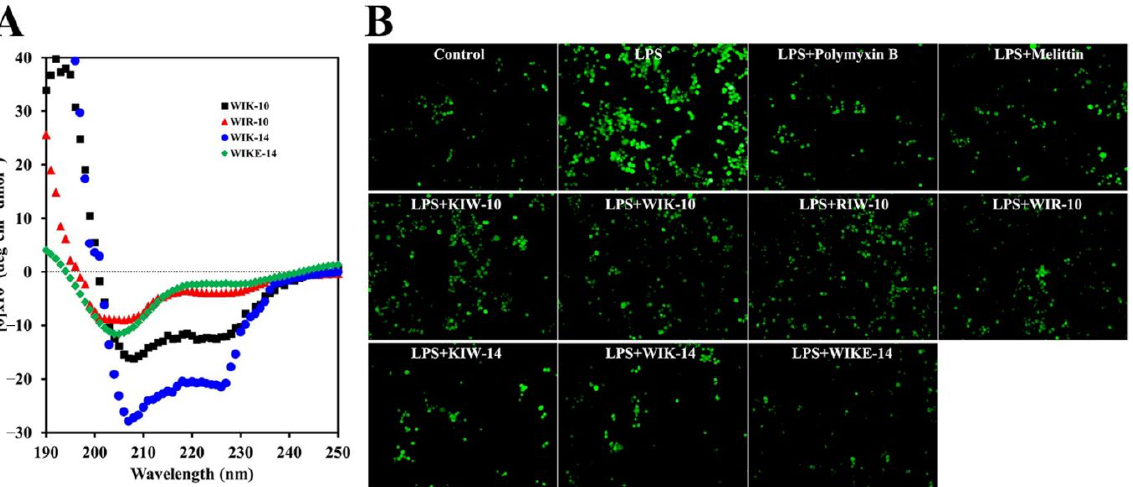
Figure 3. CD spectra of peptides in LPS and effects of peptides on reactive oxygen species (ROS) production. ( A ) Secondary structures of WIK-10, WIR-10, WIK-14, and WIKE-14 peptides (50 µM) in 1 µg/mL Pseudomonas aeruginosa LPS. ( B ) RAW 264.7 cells were pre-incubated in the absence or presence of peptides (8 µM) for 30 min and treated with or without LPS (100 ng/mL). After 24 h incubation, the cells were treated using H 2 DCFDA and incubated for 10 min, following which the fluorescent cells were observed under a fluorescence